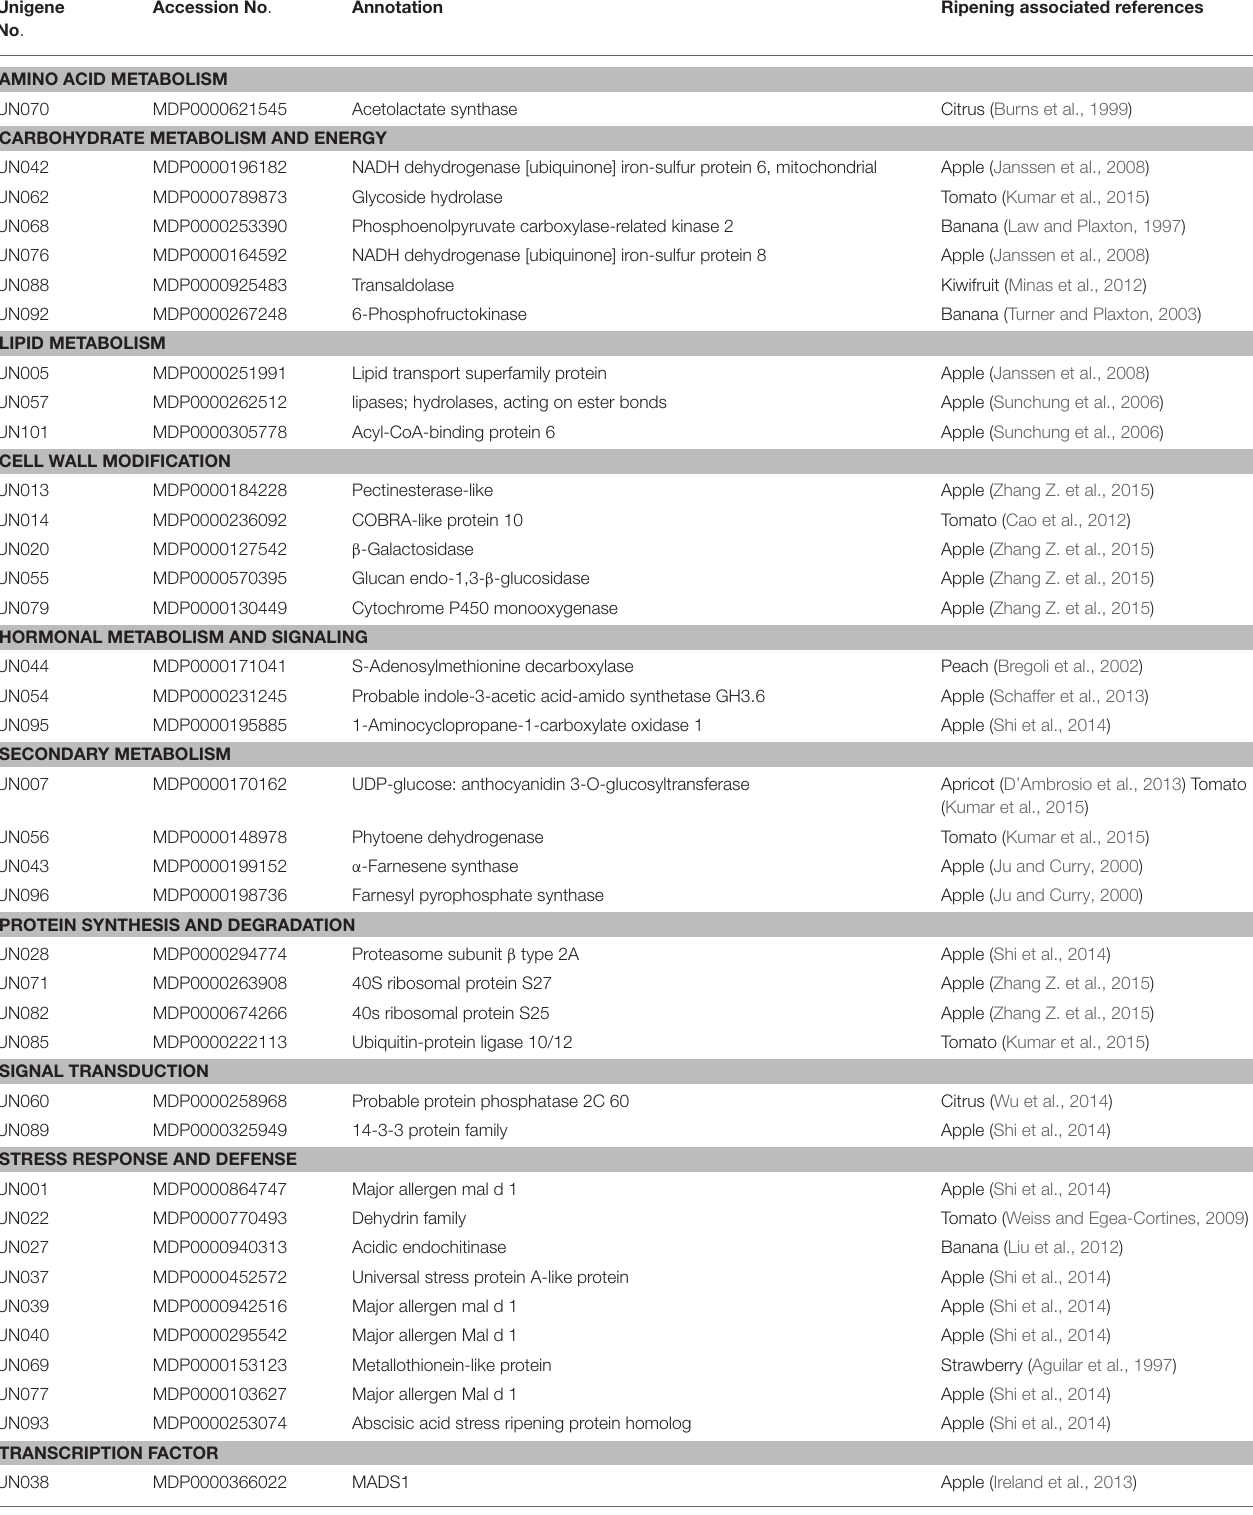
TABLE 2 | Selected fruit ripening-related genes differentially expressed in ALA-treated apple skin. Unigene No